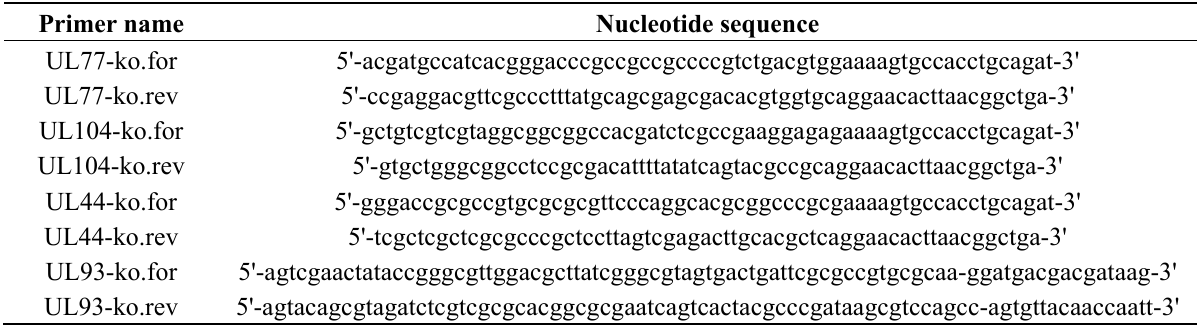
Table 2. Oligonucleotides used for HCMV BAC